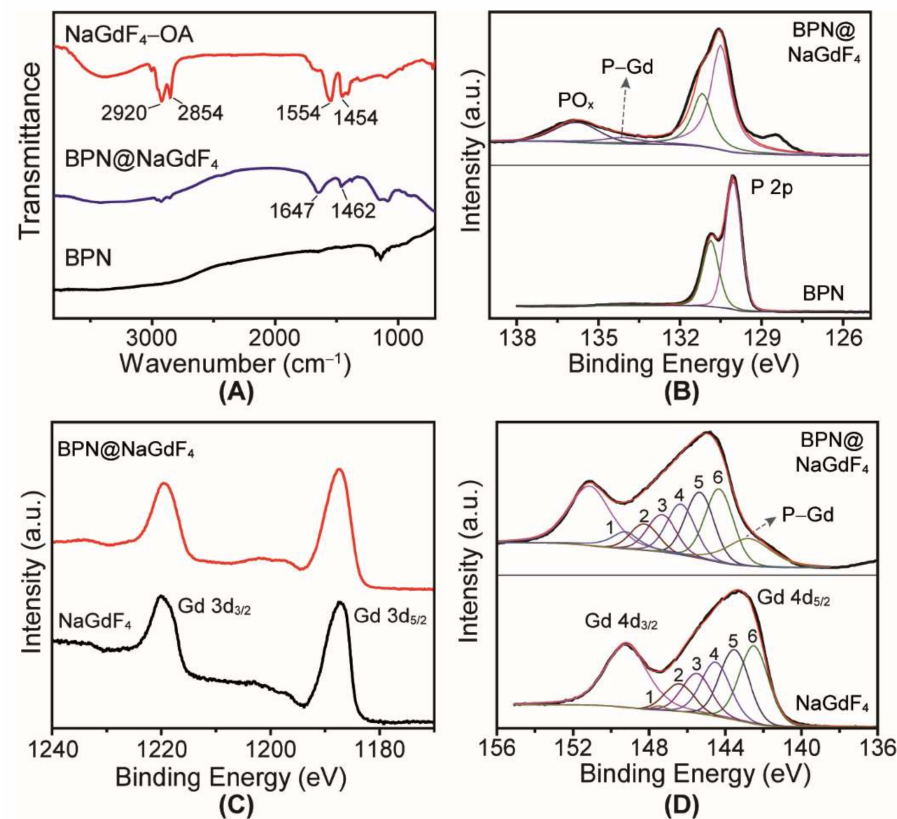
Figure 4. ( A ) FTIR spectra of BPN, NaGdF 4 , and BPN@NaGdF 4 nanocomposites; ( B ) high-resolution P 2p XPS spectra of BPN and BPN@NaGdF 4 nanocomposites; high-resolution Gd 3d ( C ) and Gd 4d ( D ) XPS spectra of NaGdF 4 and BPN@NaGdF 4